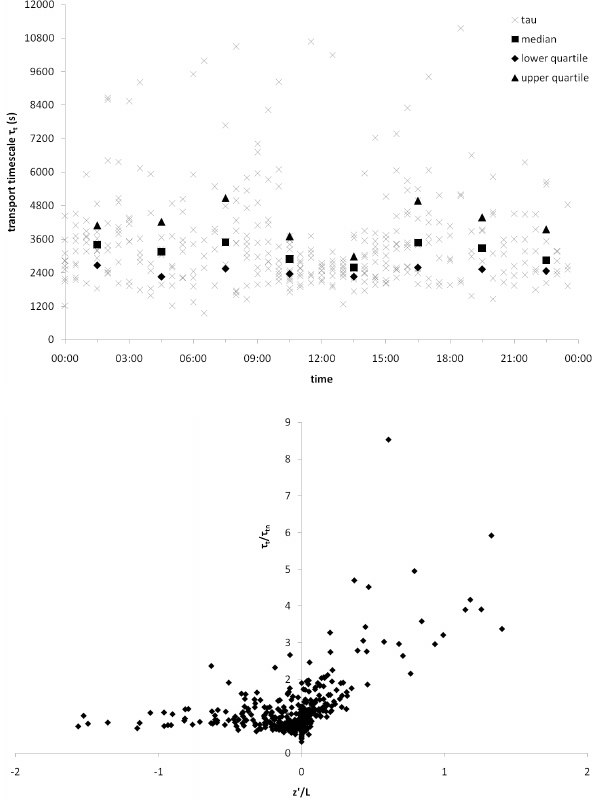
Figure 7. Transport timescale τ t calculated for REPARTEE II. a) diurnal cycle throughout campaign. Median, upper and lower quartile values calculated over 3 hour periods also shown.